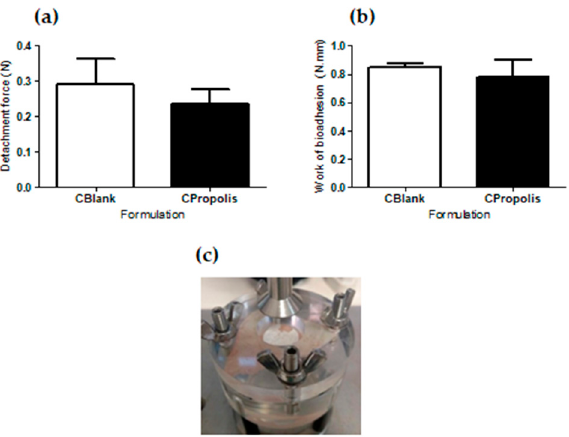
Figure 3. Bioadhesive properties of the creams: ( a ) detachment force; ( b ) work of bioadhesion; ( c ) representative photograph of the rupture of the bioadhesive bond between pig ear skin and cream ( t -test, p > 0.05) ( n = 5).